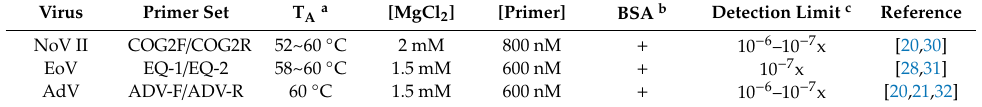
Table 4. Optimized amplification conditions and detection limits of successful primer